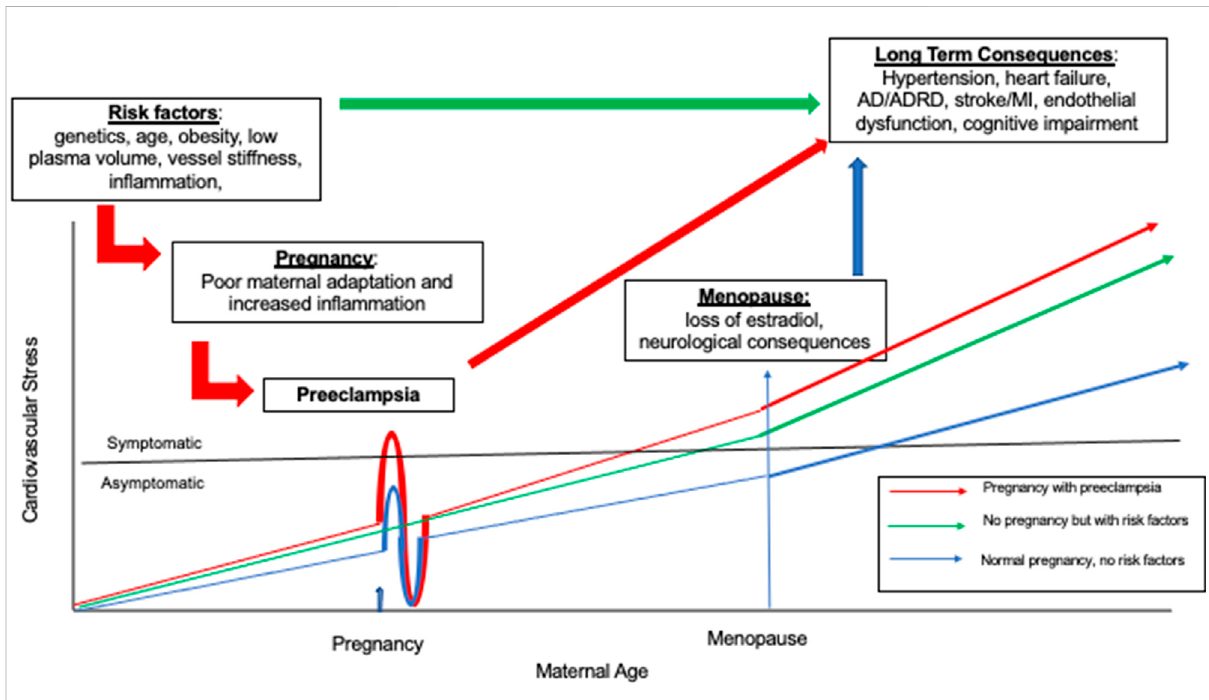
FIGURE 1 Is a model of the how women ’ s reproductive life events unmask different cardiovascular, metabolic, brain risk trajectories illustrating the relationship between cardiovascular stress and maternal age. The fi rst clinical event identifying an individual ’ s increased risk pro fi le is the developmentofpreeclampsiainpregnancy.Thenasagingcontinues,thesesameriskfactorsin fl uencelongtermhealthconsequencessuchasheart disease and Alzheimer ’ s Disease (AD). Three patterns are represented. There is variability round each of these patterns and not all women are symptomaticforcardiovascularstress.Theredlineillustrateswomenwhohaveunderlyingcardiovascularandmetabolicriskfactorswhothenhavea pregnancy. These women are highly likely to experience preterm preeclampsia during pregnancy with clinically signi fi cant symptoms of preeclampsia such as hypertension and proteinuria. After a fi rst pregnancy there is some short-term protection for subsequent pregnancies representedbytheundershoot, but thisprotectionistimelimitedand therisksfor poorhealth outcomesincrease asaging continues.Thegreen line represents a woman with cardiac and metabolic risk factors who does not have a pregnancy but still is at increased risk for poor cardiac, metabolic, and brain outcomes. The blue line represents a woman with no risk factors and a normal pregnancy. As each woman ages, the long term consequences of events that occur earlier in life become increasingly relevant for brain